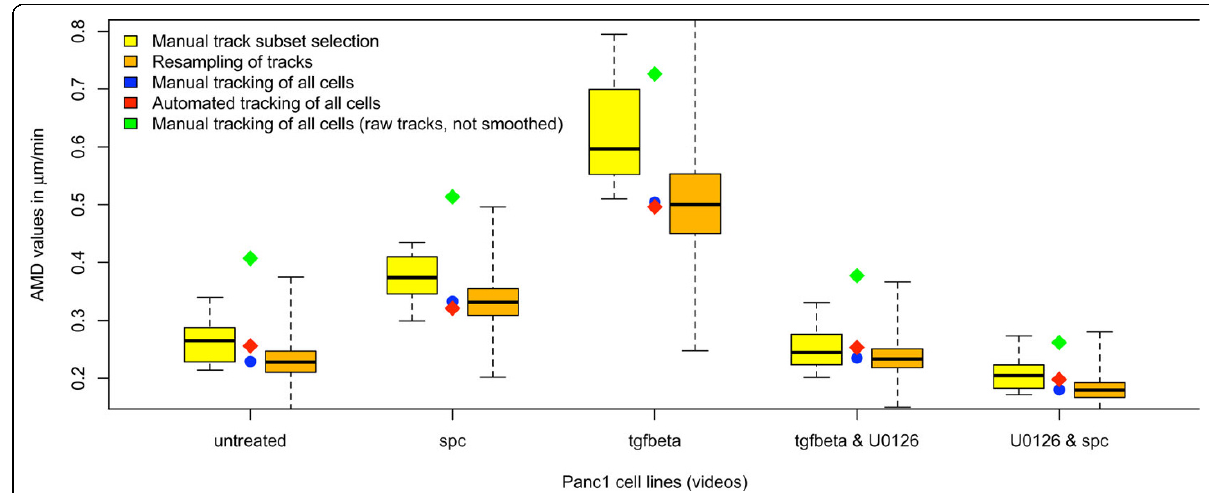
Figure 1 Dependency of average mean displacement on track selection . Variability of track set selection for average mean displacement calculation is shown for image sequences of five Panc1 cell lines treated with different compounds (spc: Sphingosylphosphorylcholine, TGF b , U0126). All cells were tracked manually by one expert (overall track number n = 420; for cell numbers per video see Table 3). Ten subjects selected 20 of these tracks for average mean displacement calculation (yellow, boxplots showing median, interquartiles and range). Results of randomly sampling 20 of the tracks repeatedly for 2 × 10 5 times are shown as orange boxplots. Average mean displacement values, utilizing all available manually tracked cells are shown in blue (for raw not smoothed tracks in green). Results of automated tracking are given in red.